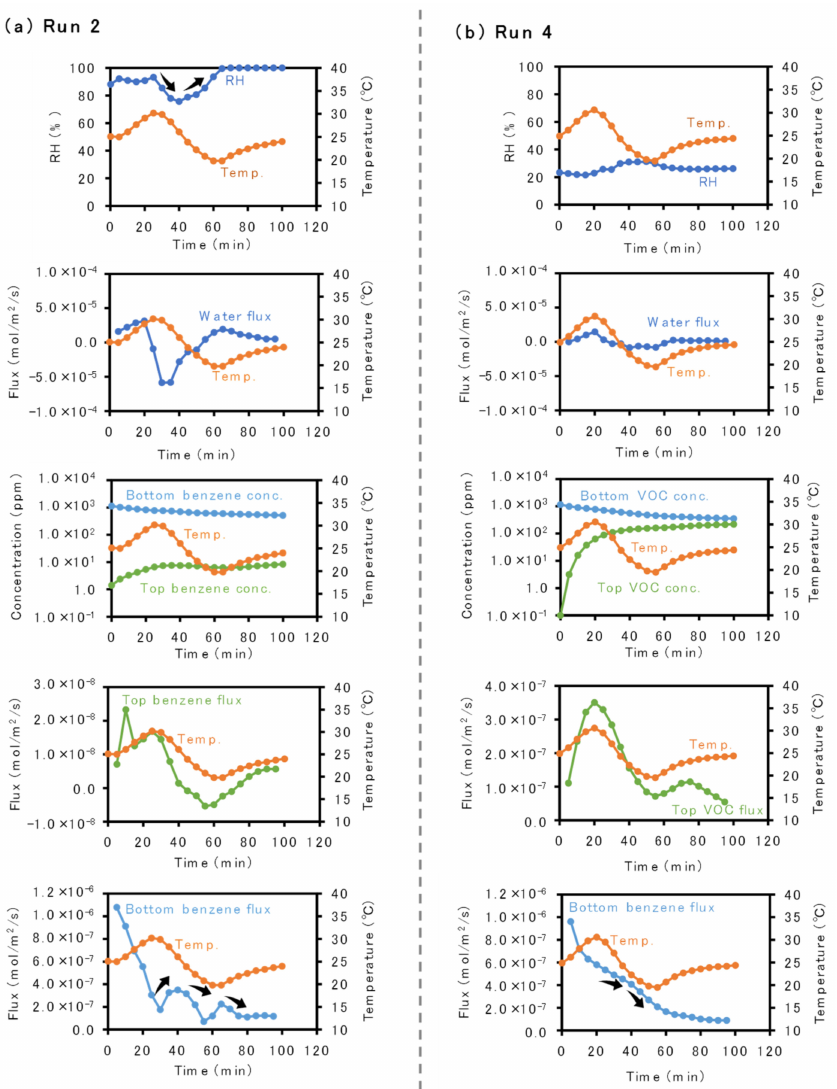
Figure 6. Changes in RH and corresponding water flux, top and bottom benzene concentrations, and corresponding top and bottom benzene fluxes in the dynamic temperature experiments Run 2 and Run 4, respectively, using coarser-grained silica sand ( a ) at 10 wt% water content and ( b ) under air-dried